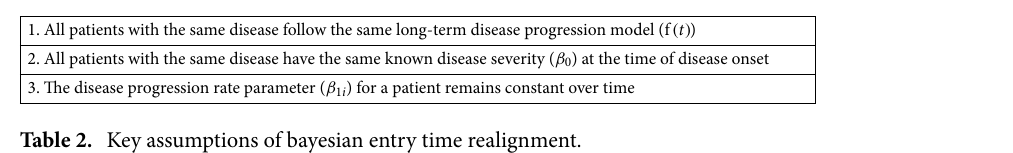
Table 2. Key assumptions of bayesian entry time